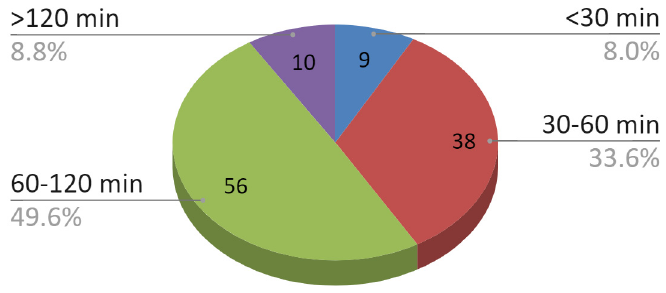
Figure 9. Duration of individual operations.